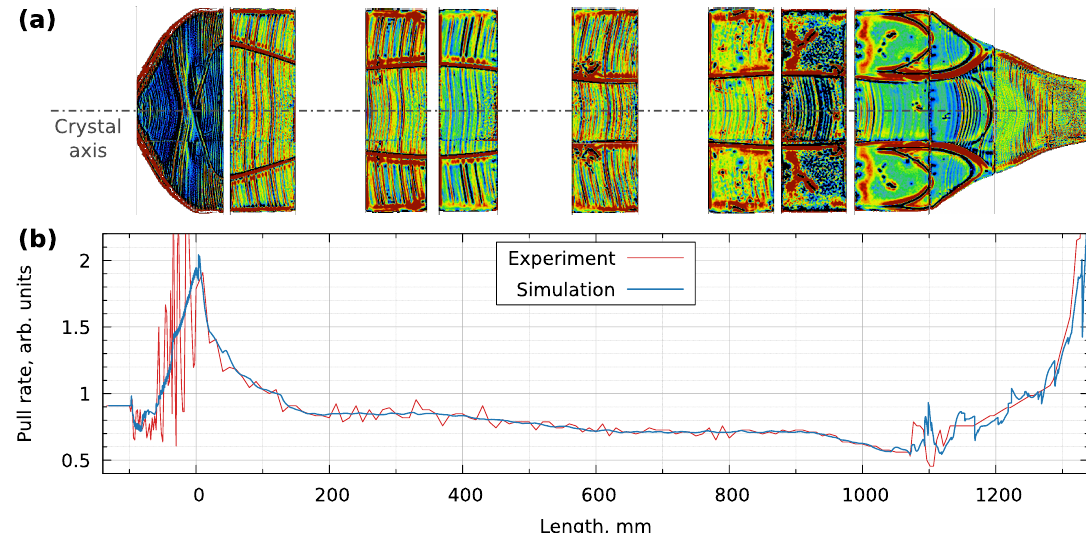
Figure 1. ( a ) Experimental µ-PCD measurements showing the IVB (part of data is mirrored to show the full crystal diameter) and ( b ) normalized crystal pull rate curve in the experiment and numerical simulations. The crystal length L is matched between ( a , b ); zero length corresponds to the beginning of the body phase, L < 0 is the cone (start